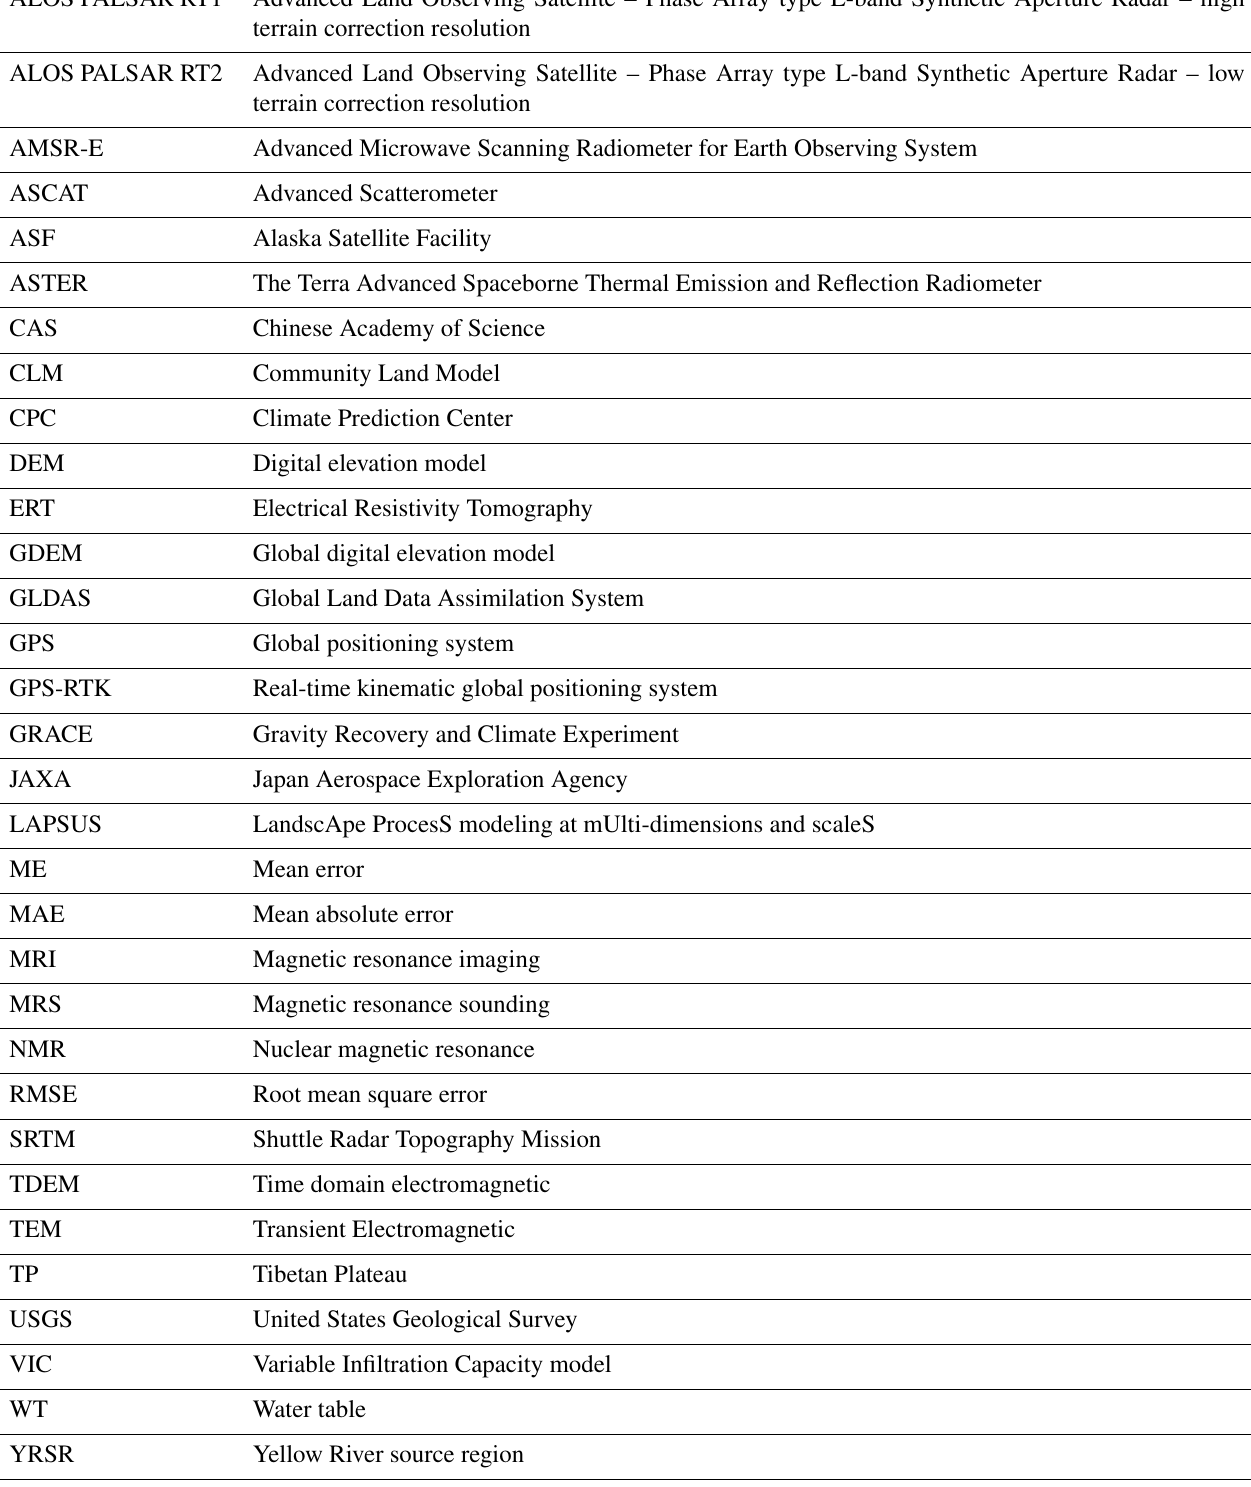
Yellow River source